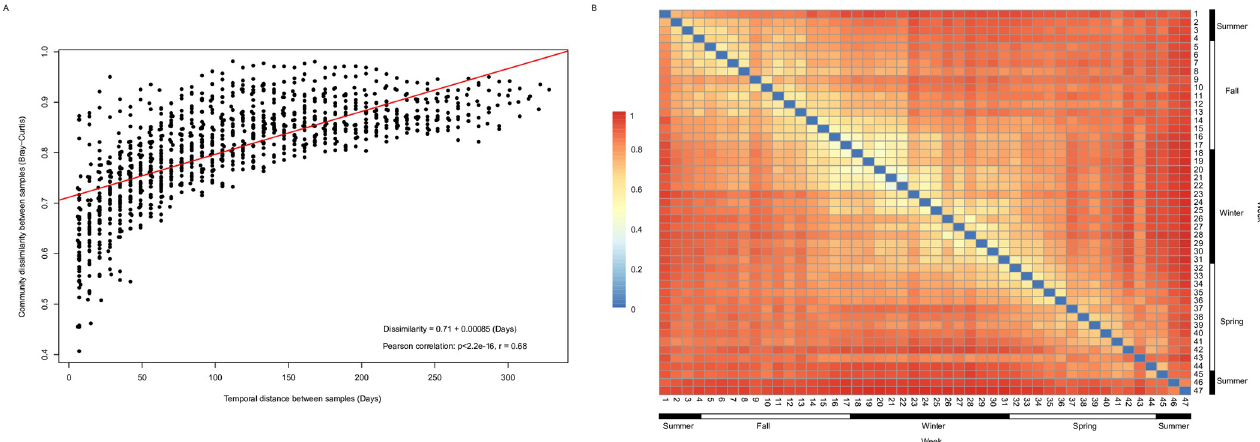
Fig 4. Analysis of the insect community composition throughout the year using the Bray-Curtis dissimilarity index. (A) Temporal decay curve for the insect community showing more dissimilarity as the samples compared are more distant in time. (B) Heat map of pairwise comparisons of the insect community. Hot colors represent high dissimilarity between samples and cold colors represent low dissimilarity between samples. The blue diagonal represents the dissimilarity of each sample compared to itself.